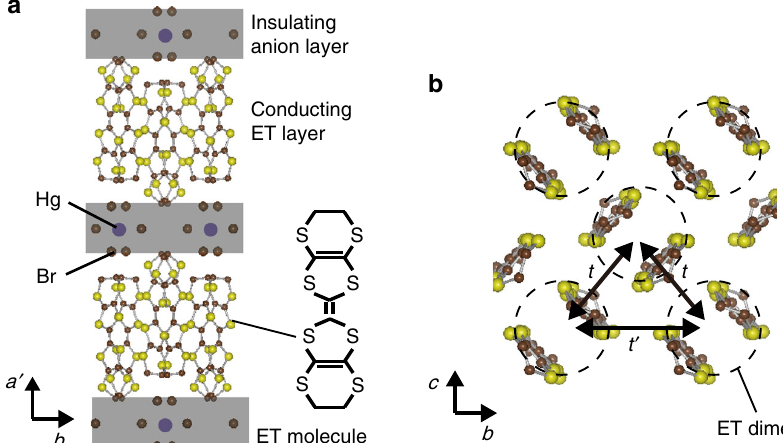
Fig. 1 Crystal structure of κ -(ET) 4 Hg 2.89 Br 8 (denoted by κ -HgBr). a ET denotes bis(ethylenedithio)-tetrathiafulvalene. b Shows the conducting ET layer, which is parallel to the b - c plane. The electronic bands of κ -ET compounds are well described by the tight binding of antibonding molecular orbitals in the ET dimers (indicated by broken circles). The lattice of dimers is modeled as a nearly isotropic triangular lattice with a t ′ / t value close to unity, where t and t ′ are the transfer integrals between the antibonding orbitals of dimers forming a conduction band 11 . The non-stoichiometric composition of Hg, 2.89, originates from the incommensurability of the Hg sublattice with the Br and ET sublattices, and is precisely known by the incommensurability determined by X-ray diffraction